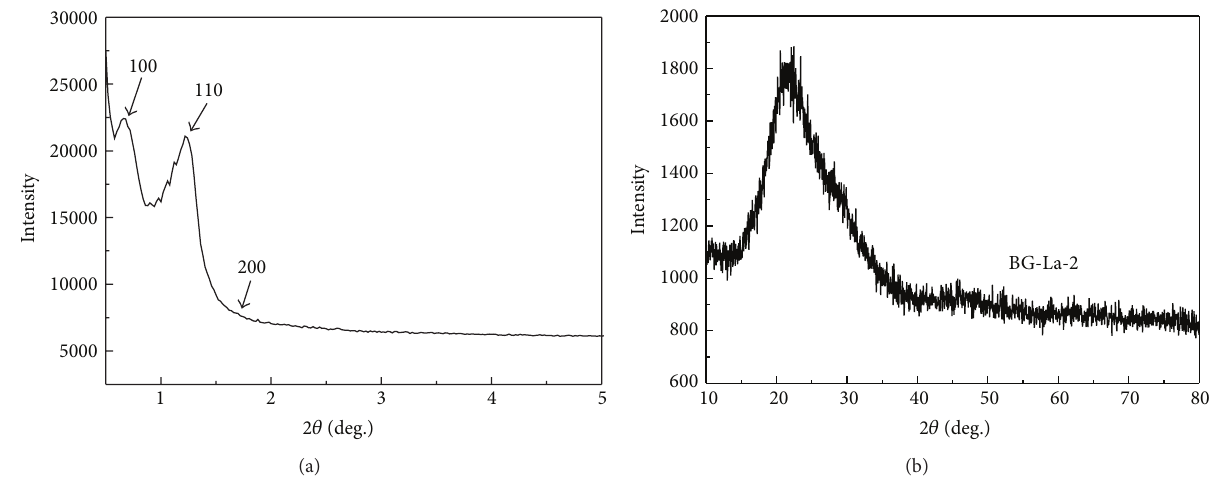
Figure 1: (a) Small-angle XRD pattern of BG-La-2; (b) XRD pattern of BG-La-2.